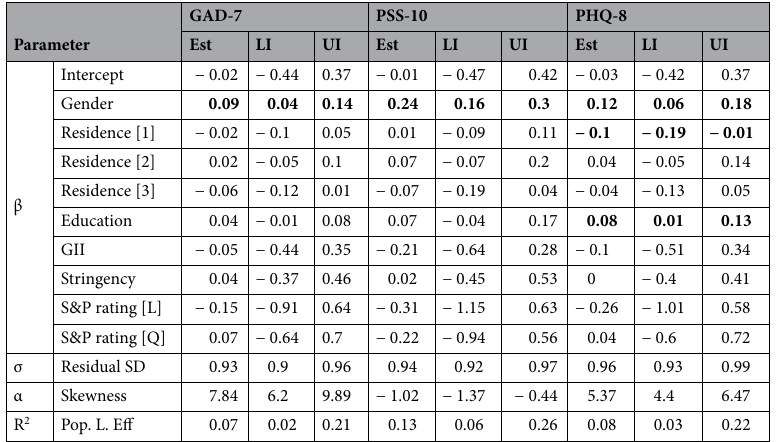
Table 4. Regression weights from the Bayesian skew-normal multilevel models. Est., posterior mean; LL and UL, lower and upper bounds of the 95% credibility interval; β, standardized regression weight. Estimations in bold are credible. Variables were coded as follows- Gender: Men = 0, Women = 1; Residence: Village = 1, Town = 2, City = 3, Agglomeration = 4; Education: Bachelor = 0, Master or higher = 1; GII: high = 0, low = 1; Stringency: high = 0, low = 1; S&P rating: 0 = low risk, 1 = medium risk, 2 = high risk (speculative); L, rating linear; Q, quadratic